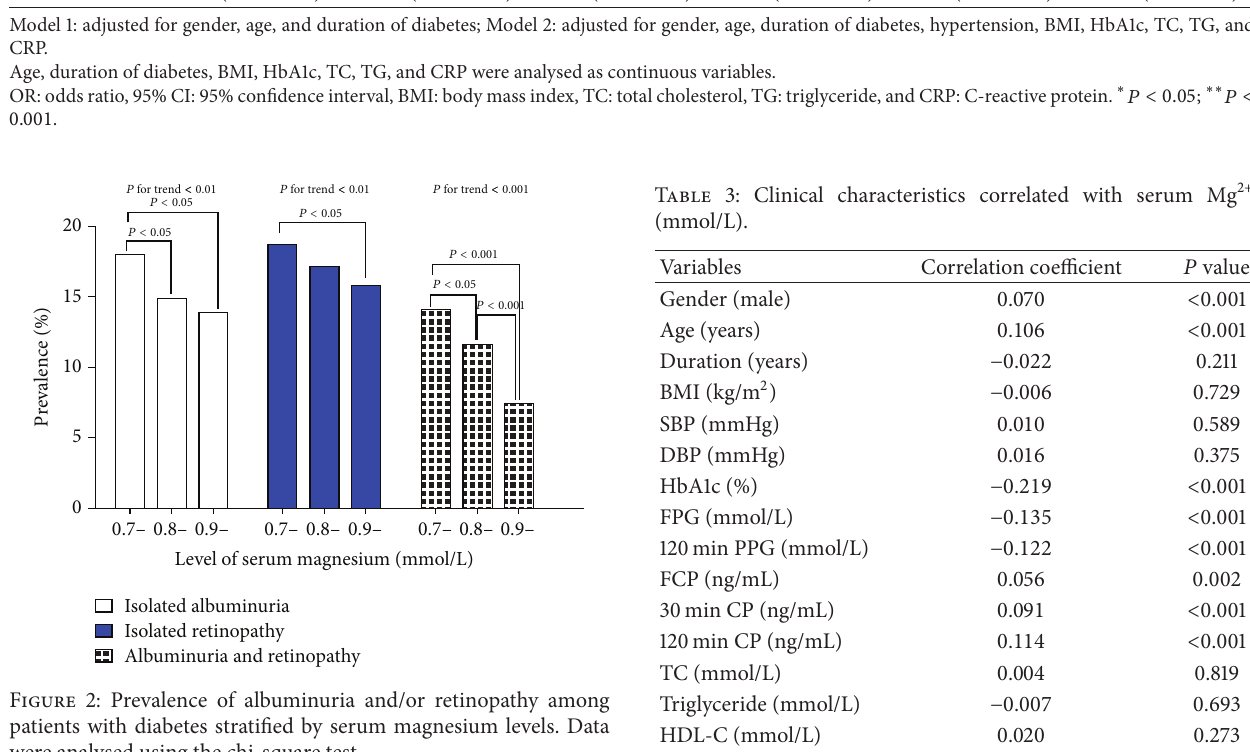
Figure 2: Prevalence of albuminuria and/or retinopathy among patients with diabetes stratified by serum magnesium levels. Data were analysed using the chi-square test.